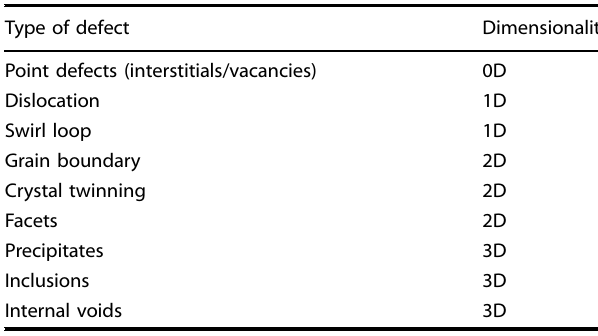
Fig. 1 µCT setup and the formation of defects. a A representation of the key components in a µCT instrument. The X-ray source shown generates X-rays in a cone-beam geometry as they transmit through the sample and hit the scintillation detector, all while the sample rotates on a stage. b A comparison of the various time and length scales defects can form in electronic and quantum materials. Table 1. Defects and their